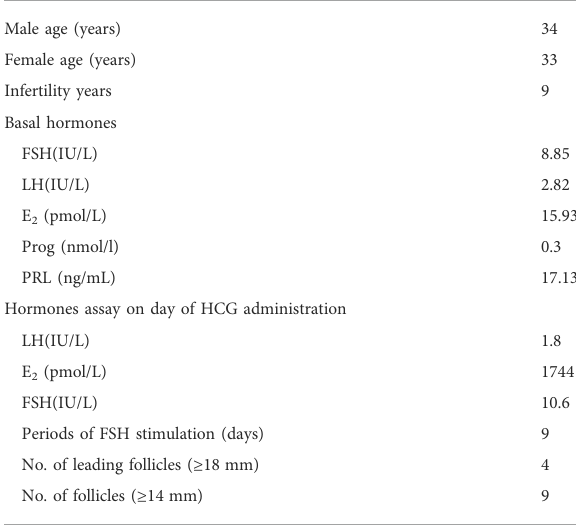
TABLE 1 Gonadotrophin stimulation and follicular responses for the IVF cycle in the